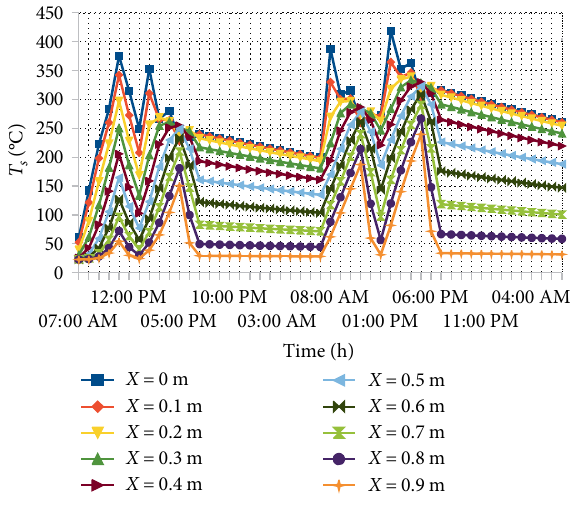
Figure 19: Temperature of storage versus time for two consecutive days.